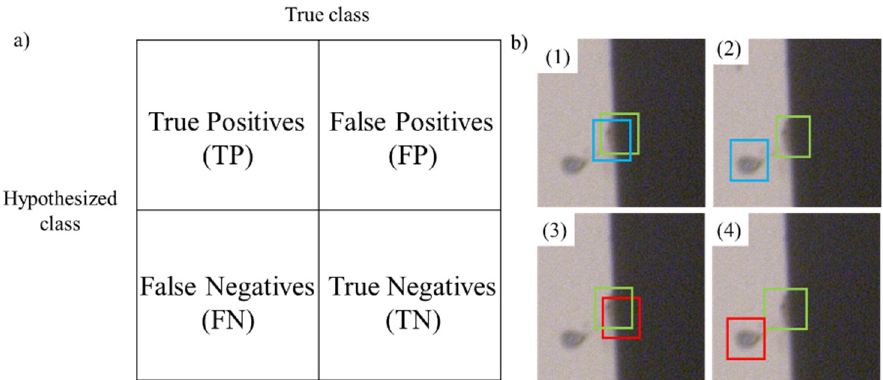
Figure 12. ( a ) Conceptual explanation of evaluation metric; ( b ) Case diagram of the diamond tool detection process. In these images, the green boxes represent the ground truth, the blue box represents that the algorithm recognizes the target as a positive example, and the red box represents that the algorithm recognizes the target as a negative example. (1)–(4) correspond to the four cases in ( a ) respectively.